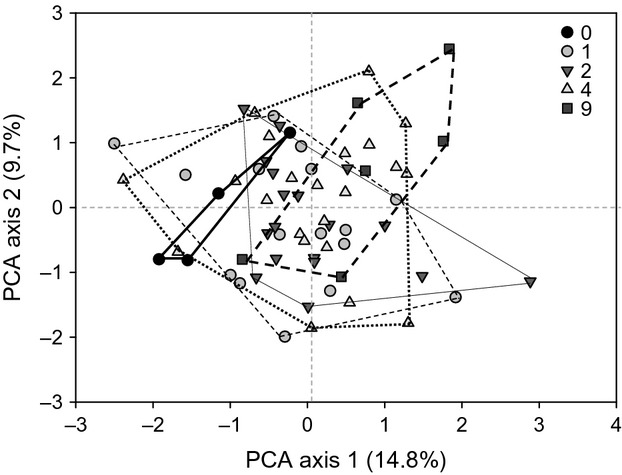
Ordination diagram of principal component analysis (PCA) of the prey nematode community in plots with 1, 2, 4, and 9 plant species and in bare plots (0). Percentages of total explained variation by PCA axes are given in parentheses.